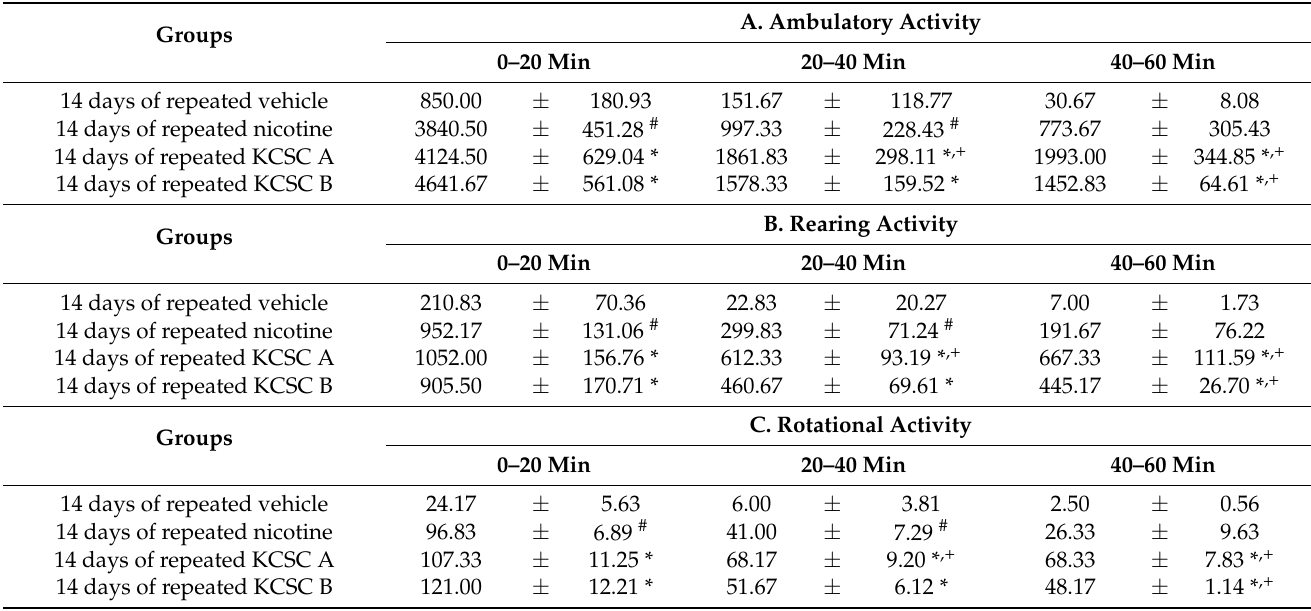
Table 2. Accumulative changes in ambulatory, rearing, and rotational activities at P1, P2, and P3 after repeated administra- tion of vehicle, nicotine, KCSC A, and KCSC